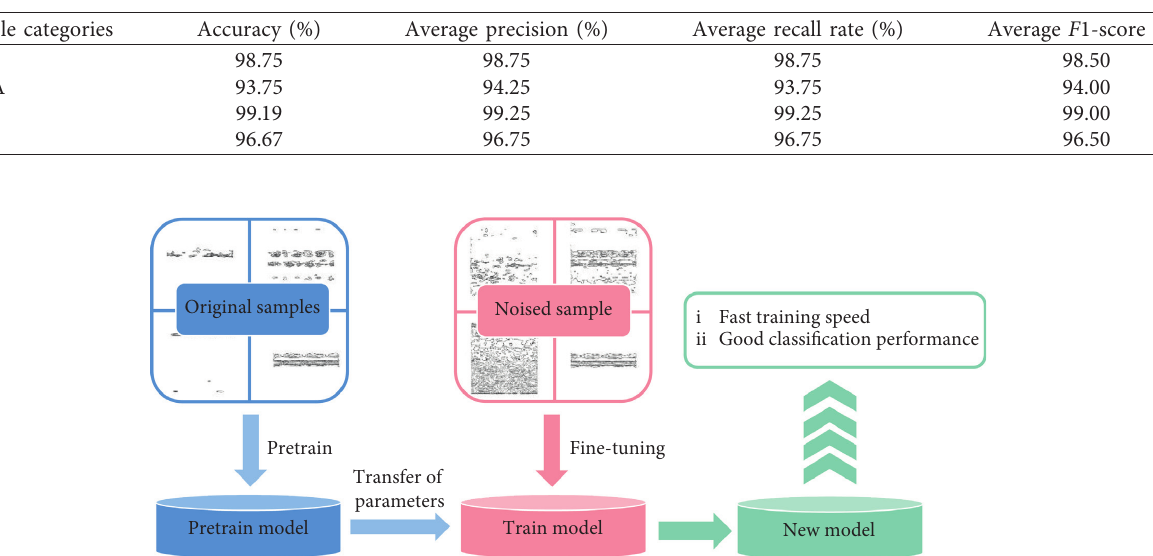
Table 9: Evaluation data of test results.